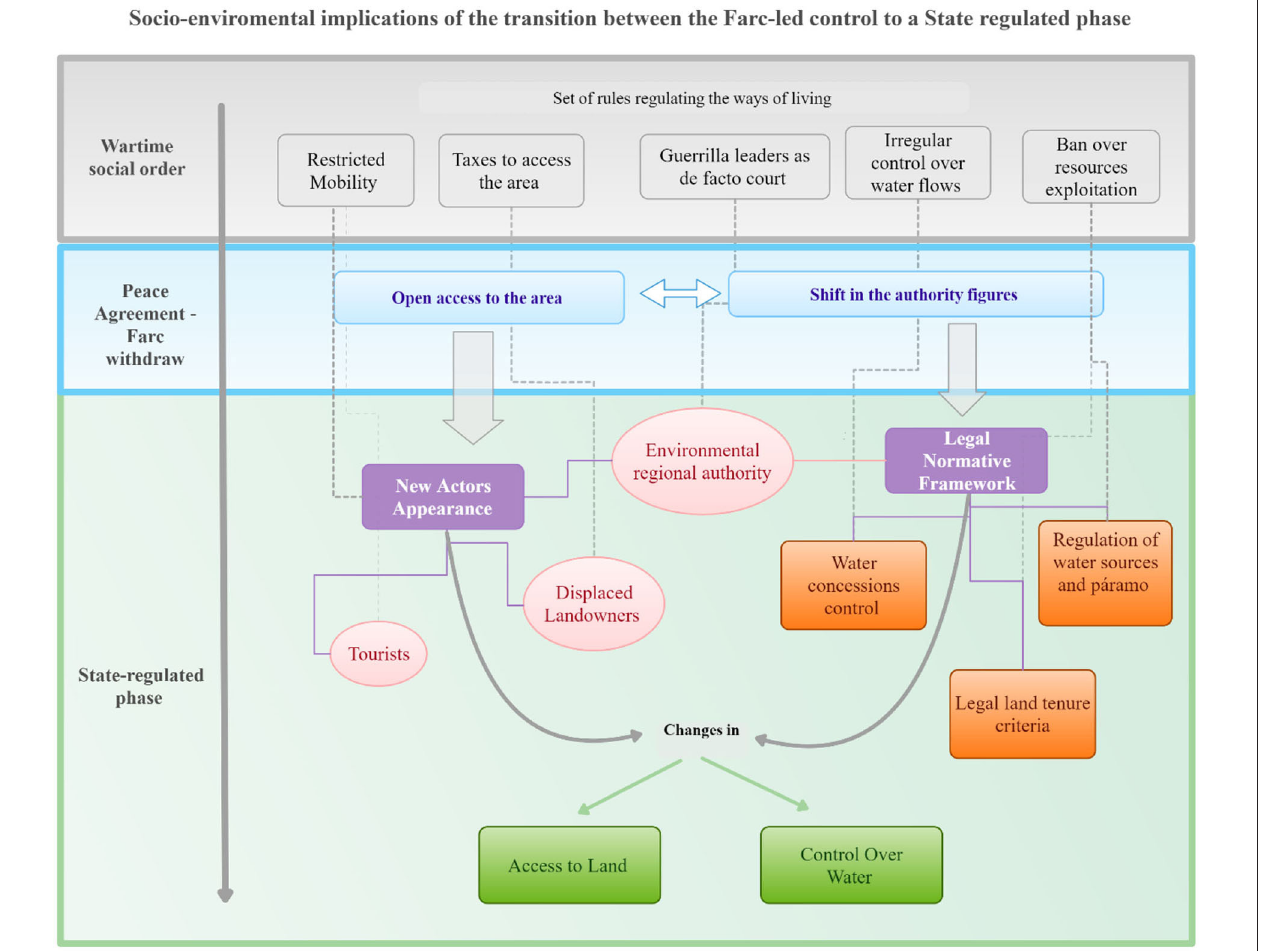
FIGURE 5 | Process of transition between wartime social order to a State-regulated phase. The orange boxes indicate regulatory changes, pink boxes refer to new actors in the area and green boxes changes in access to land. (Source: Own